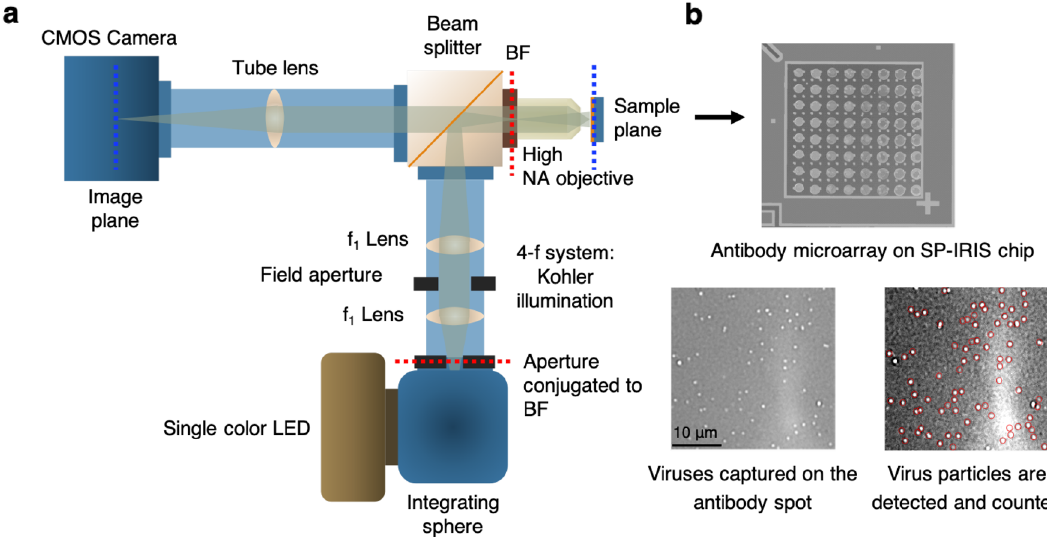
Figure 1. Optical setup of SP-IRIS and virus visualization using SP-IRIS platform. ( a ) Optical setup of SP-IRIS system (BF: Back focal plane) ( b ) Top part shows an SP-IRIS chip with an antibody microarray printed on. The image was taken with low-magnification modality of IRIS system. Each antibody spot is about 150 µm in diameter. Bottom images are zoomed in antibody spots from an SP-IRIS image following an incubation with the specific virus sample. Virus particles appear as white dots and they are detected (red circles) and counted using custom